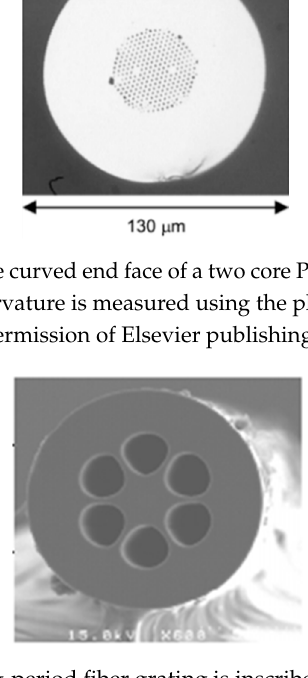
Figure 22. In this hollow fiber long-period fiber grating is inscribed and used for bending properties measurement (Reproduced from [87], with the permission of OSA publishing).